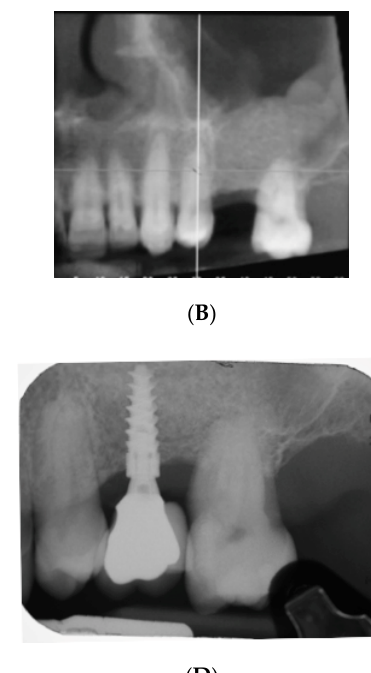
Figure 1. Radiographic images of a case with a residual bone height of 1 mm: ( A ) presurgical cone beam computed tomography (CBCT) showing the posterior residual bone; ( B ) image taken soon after the procedure of lateral sinus lift; ( C ) implant positioned after 5 months; ( D ) 1-year follow-up after loading.